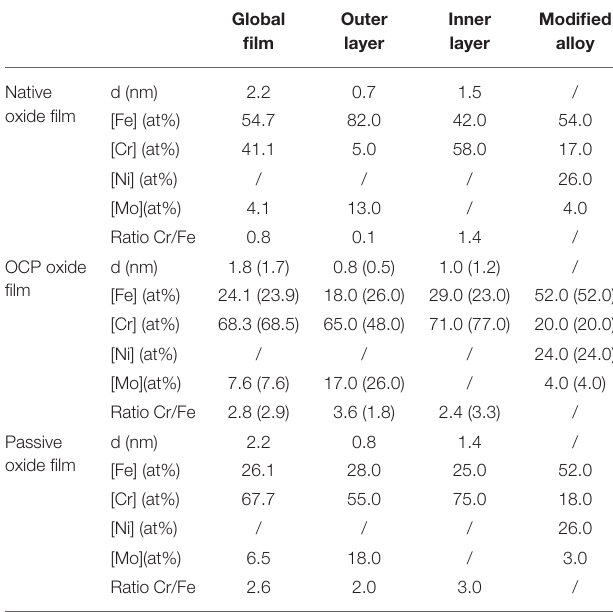
TABLE 2 | Thickness and composition of the air-formed native oxide film on polycrystalline 316L SS and variations after immersion for 30min at OCP in 0.05M H 2 SO 4 , and after passivation for 30min at 0.5 V/SCE in 0.05M H 2 SO 4 as calculated from the XPS